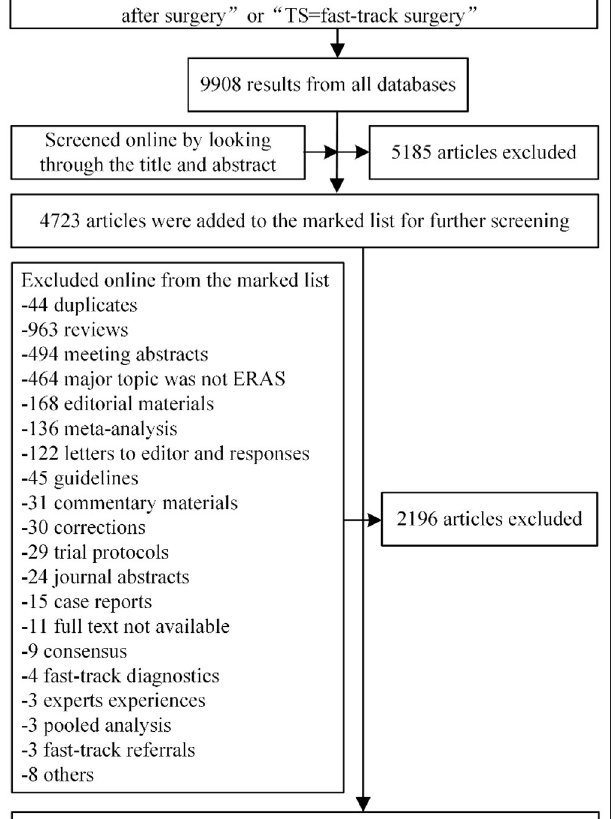
FIGURE 1 | Flowchart of article